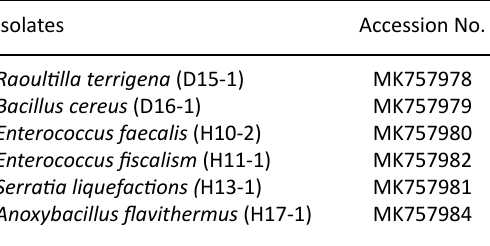
table 7. Results of Blast search for DNA sequence in NCBI Genbank